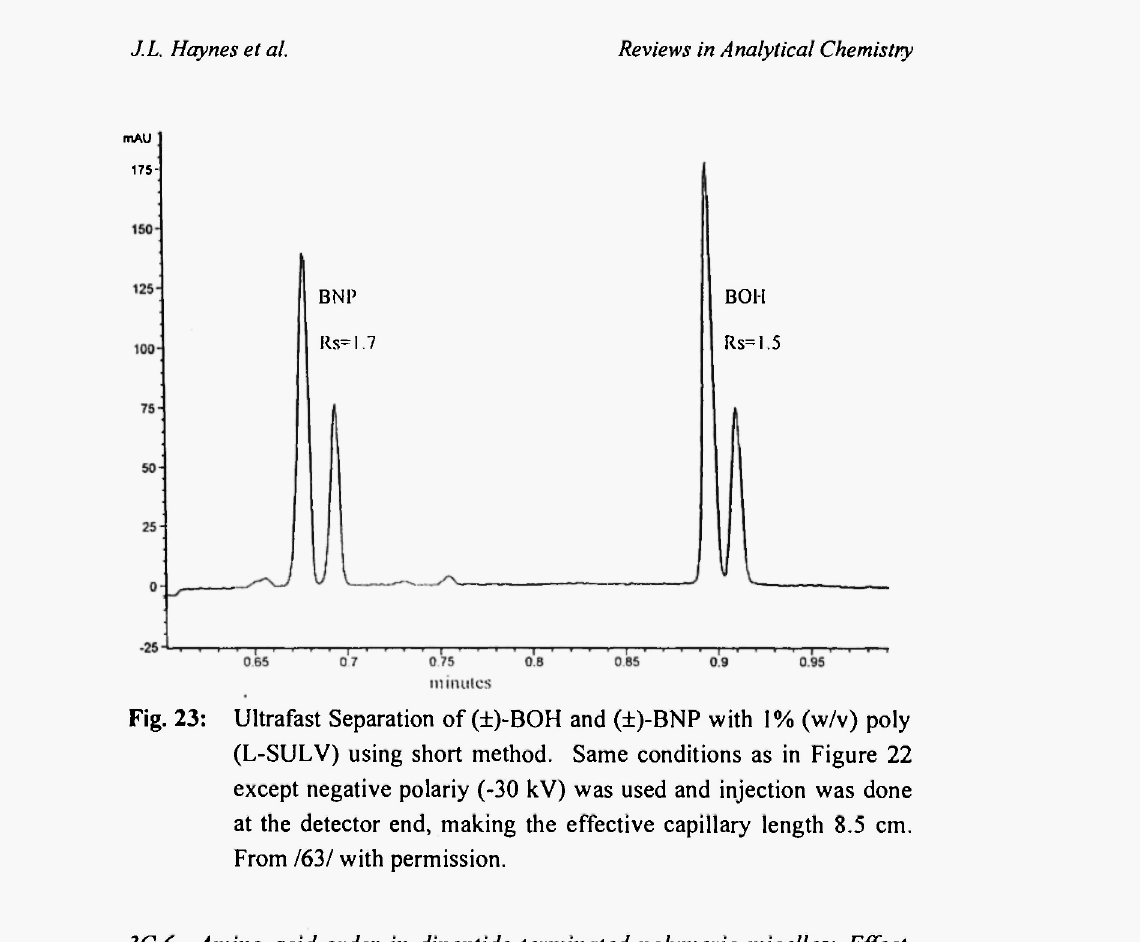
Fig. 23: Ultrafast Separation of (±)-BOH and (±)-BNP with 1% (w/v) poly (L-SULV) using short method. Same conditions as in Figure 22 except negative polariy (-30 kV) was used and injection was done at the detector end, making the effective capillary length 8.5 cm. From 763/ with